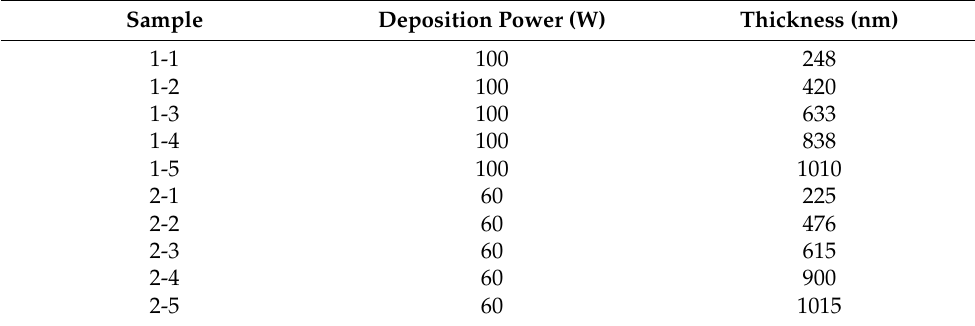
Table 1. The information of the as-deposited Y 2 O 3 thin